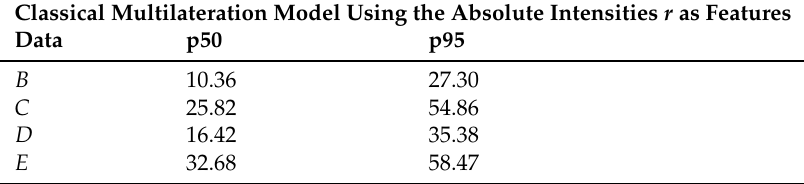
Table 5. The p50 and p95 percentiles of the error expressed in (cm) for the classical multilateration algorithm. Classical Multilateration Model Using the Absolute Intensities r as Features Data p50